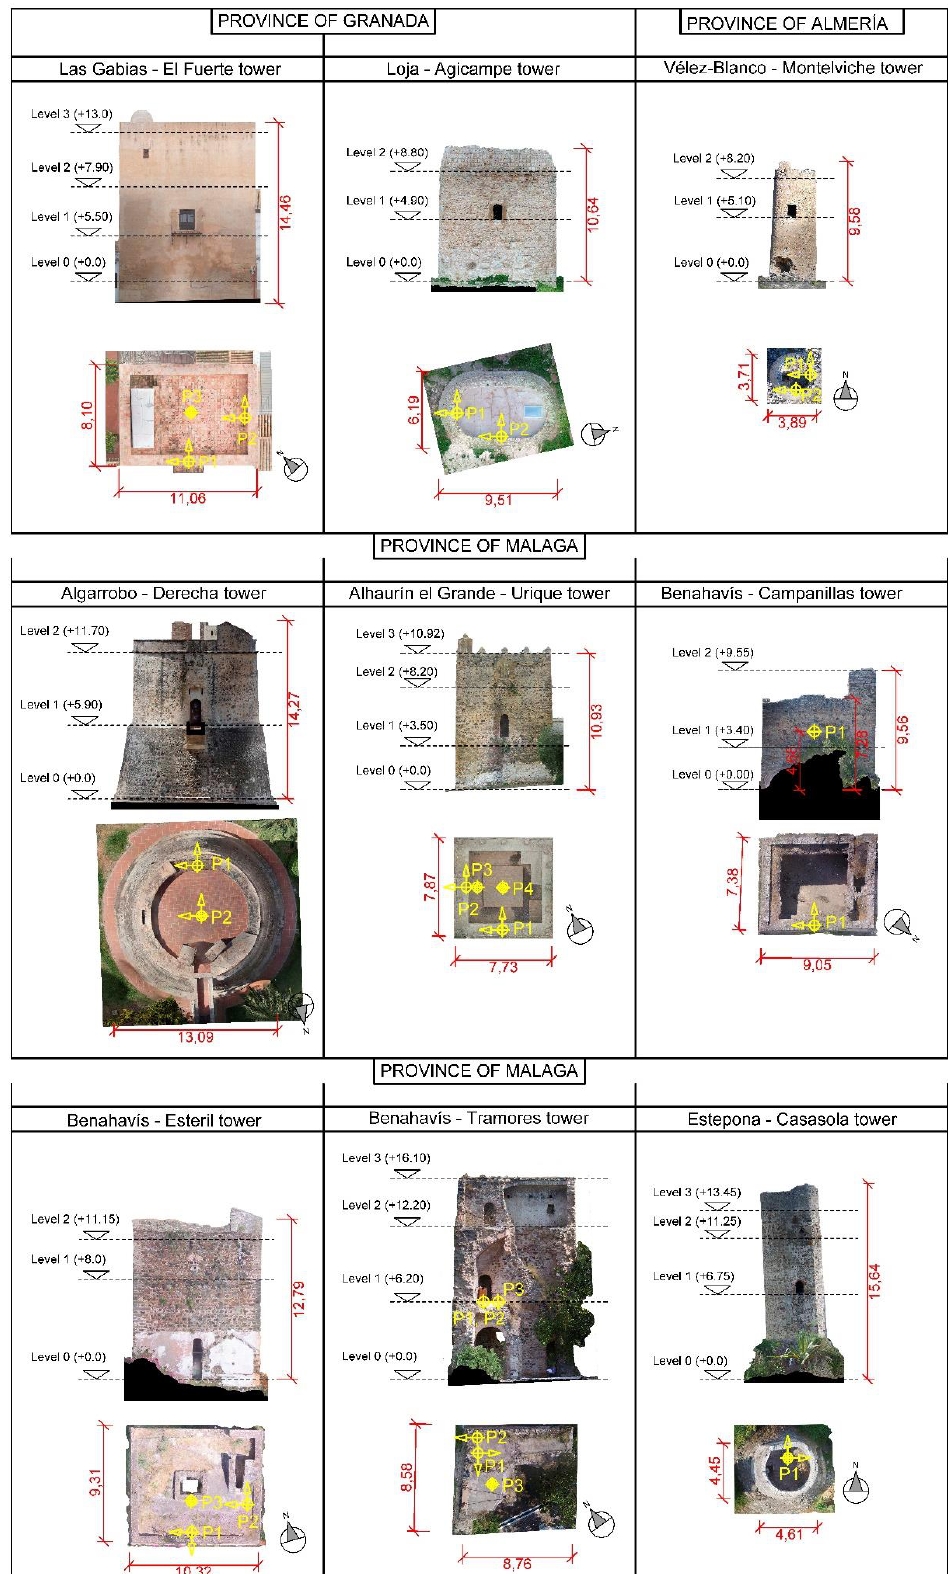
Figure 9. Points where ambient vibration testing was carried out. Towers are sorted by the provinces where they are located — Granada, Almeria and Malaga, — and by municipality.